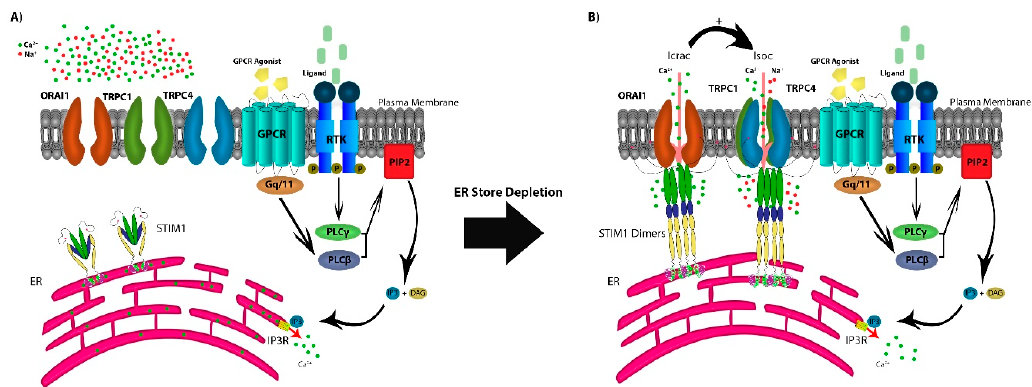
Figure 1. The store-operated Ca 2 + entry pathway (SOCE). ( A ) SOCE is regulated by agonist binding to G-protein coupled receptors (GPCRs) or receptor tyrosine-kinases (RTKs), activating phospholipase C β (PLC β ) via Gq / 11 and PLC γ via RTK-mediated signaling, resulting in the production of IP3 and DAG from the cleavage of plasma-membrane PIP2. IP3 depletes Ca 2 + stores from the ER through the IP3R which is sensed by STIM1. ( B ) STIM molecules multimerize forming puncta and translocate to the ER–PM junction, co-assembling with the CRAC channel subunits ORAI1, activating the Ca 2 + selective Icrac currents. Further, STIM1 forms the STIM1-ORAI1-TRPC1 complex activating cation non-selective Isoc currents.